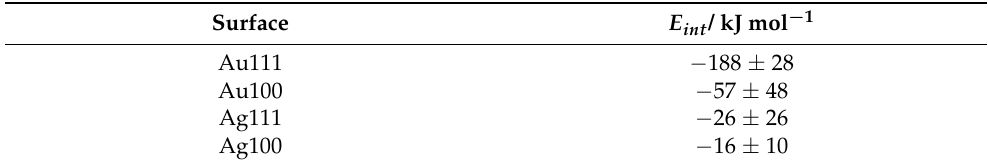
Table 1. Peptide–surface interaction energies calculated from MD simulations, uncertainties estimated from standard deviation.